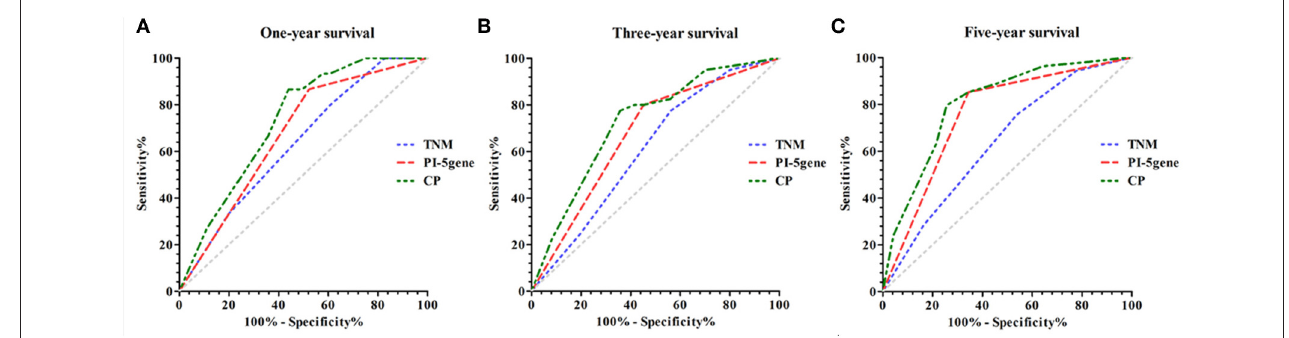
FIGURE 4 | Comparison of predictive performance for PI-5, TNM stage and CPI. (A) 1-year survival. (B) 3-year survival. (C) 5-year